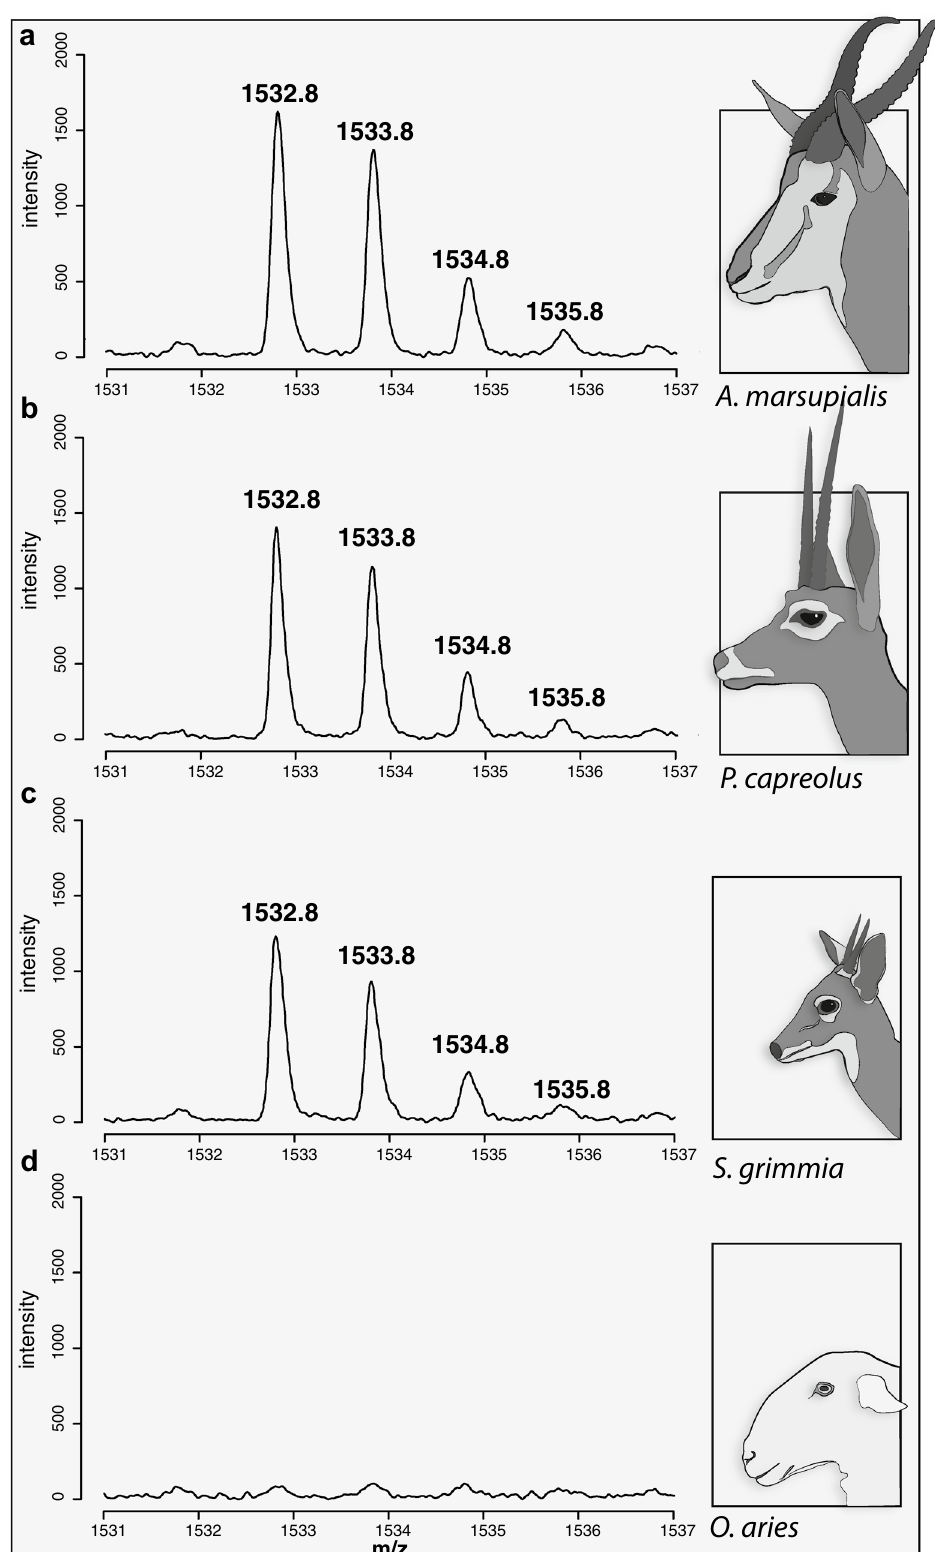
Figure 2. Presence and absence of species-specific mass ions in four ZooMS spectra. ( a – c ) Reference spectra of modern springbok, grey rhebok and common duiker show the presence of peptide with a m/z of 1532.8 and related ions. ( d ) Modern sheep reference spectrum showing the absence of the peptide with a m/z of